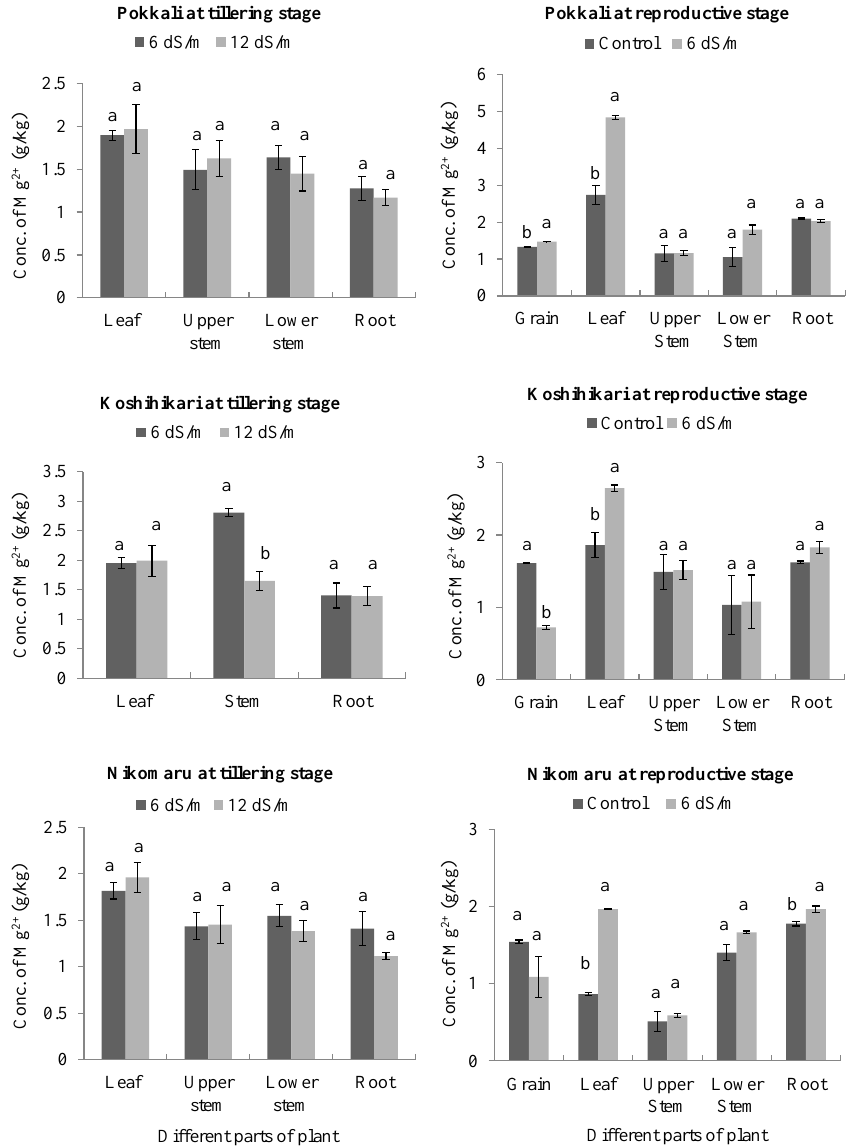
Figure 5. Average concentration of magnesium ions in different parts of the rice plant body in the tillering stage (under 6 and 12 dS/m saline irrigation) and in the reproductive stage (under control and 6 dS/m saline irrigation). Error bars represent standard errors ( n = 6). Different letters on bars indicate statistical difference at p ≤